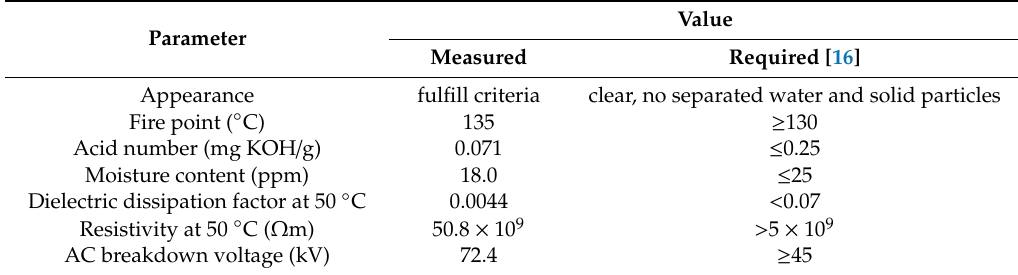
Table 6. Results of the measurements of oil sample taken from a 40 / 20 / 20 MVA, 115 / 16.5 / 16.5 kV power transformer.